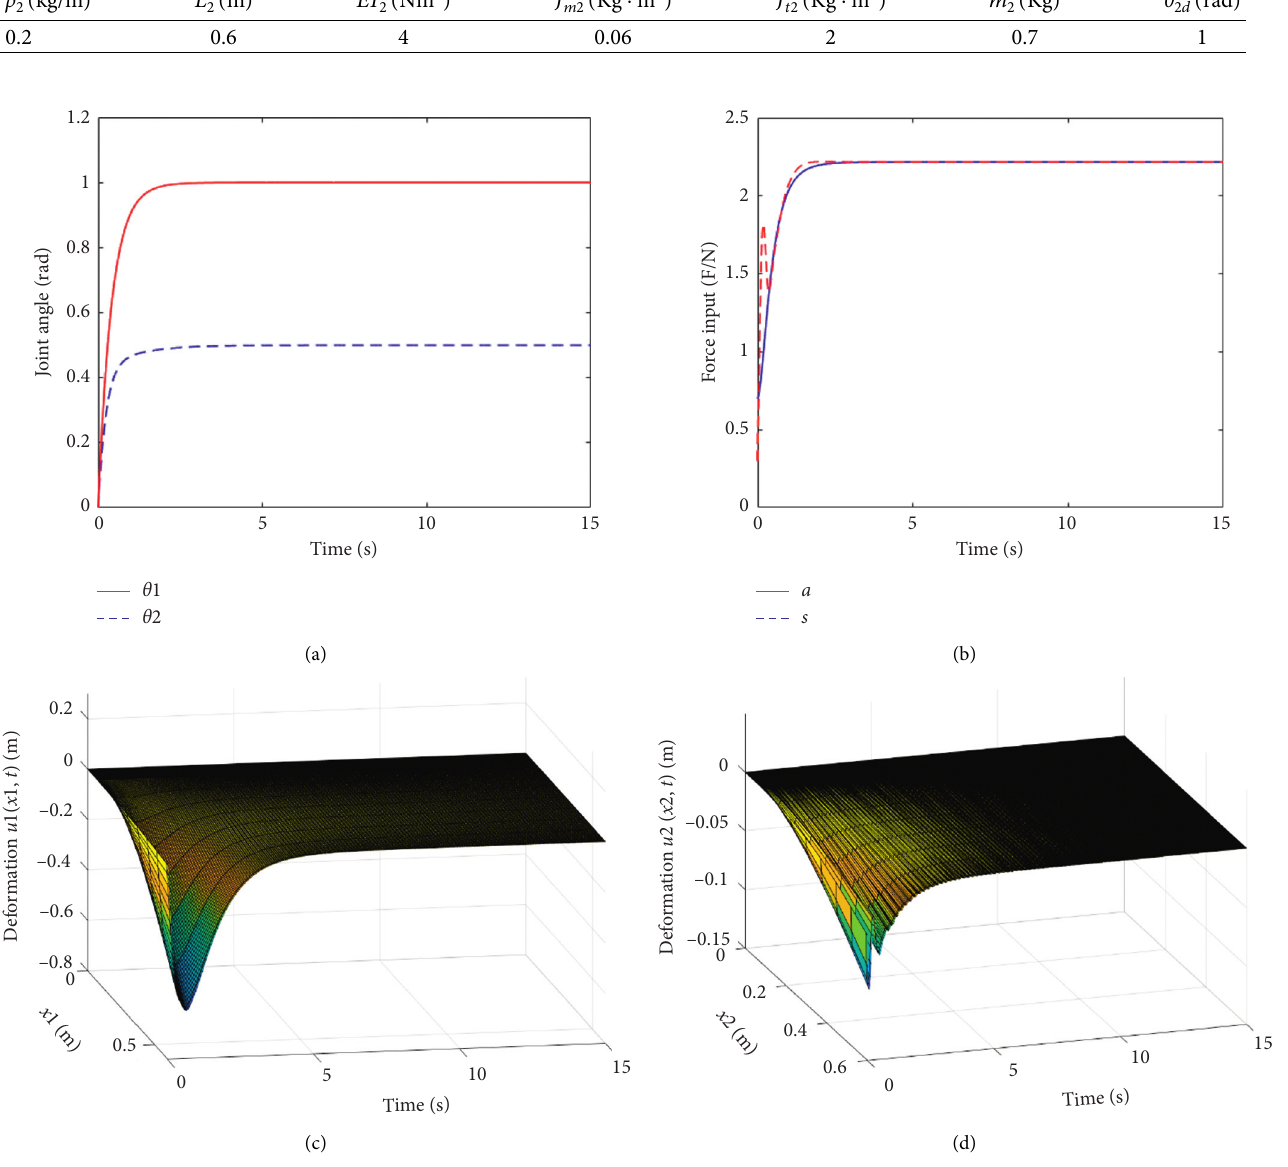
Figure 9: Comparison with the pure boundary control method. (a) Actual joint angles of the two links. (b) Uncertain function approach effect. (c) The deformation of link 1. (d) The deformation of link 2.